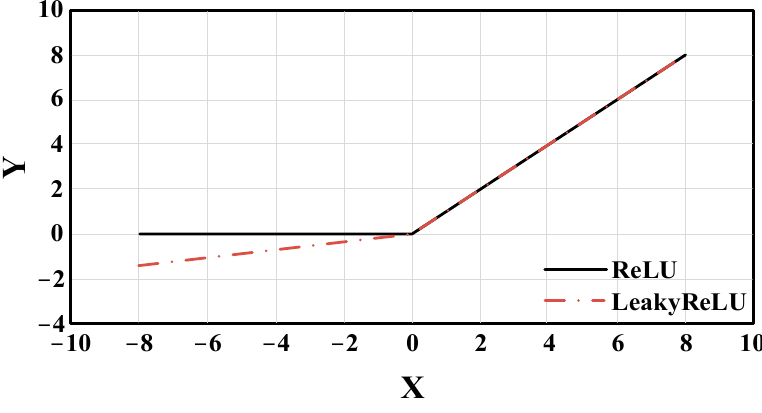
Figure 12. Graph of LeakyReLU and ReLU activation function.